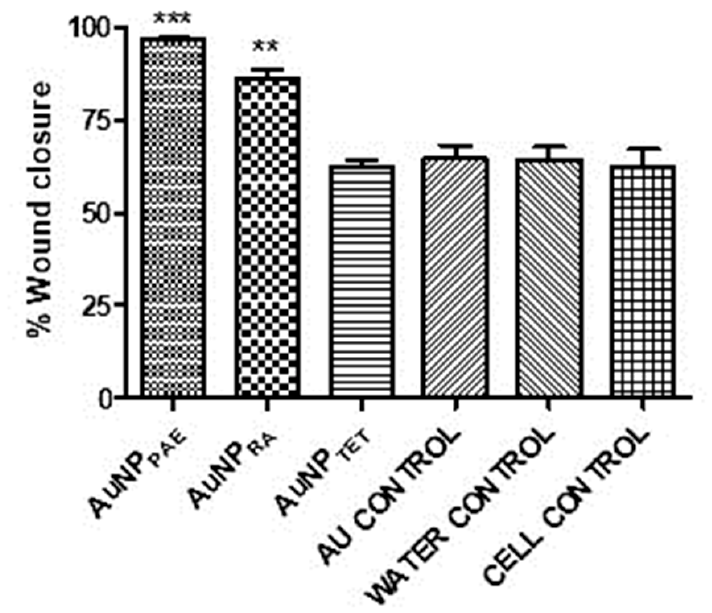
Figure 4. Percentage wound closure at 25% v / v . AuNP PAE : gold nanoparticles formed from Plectran-